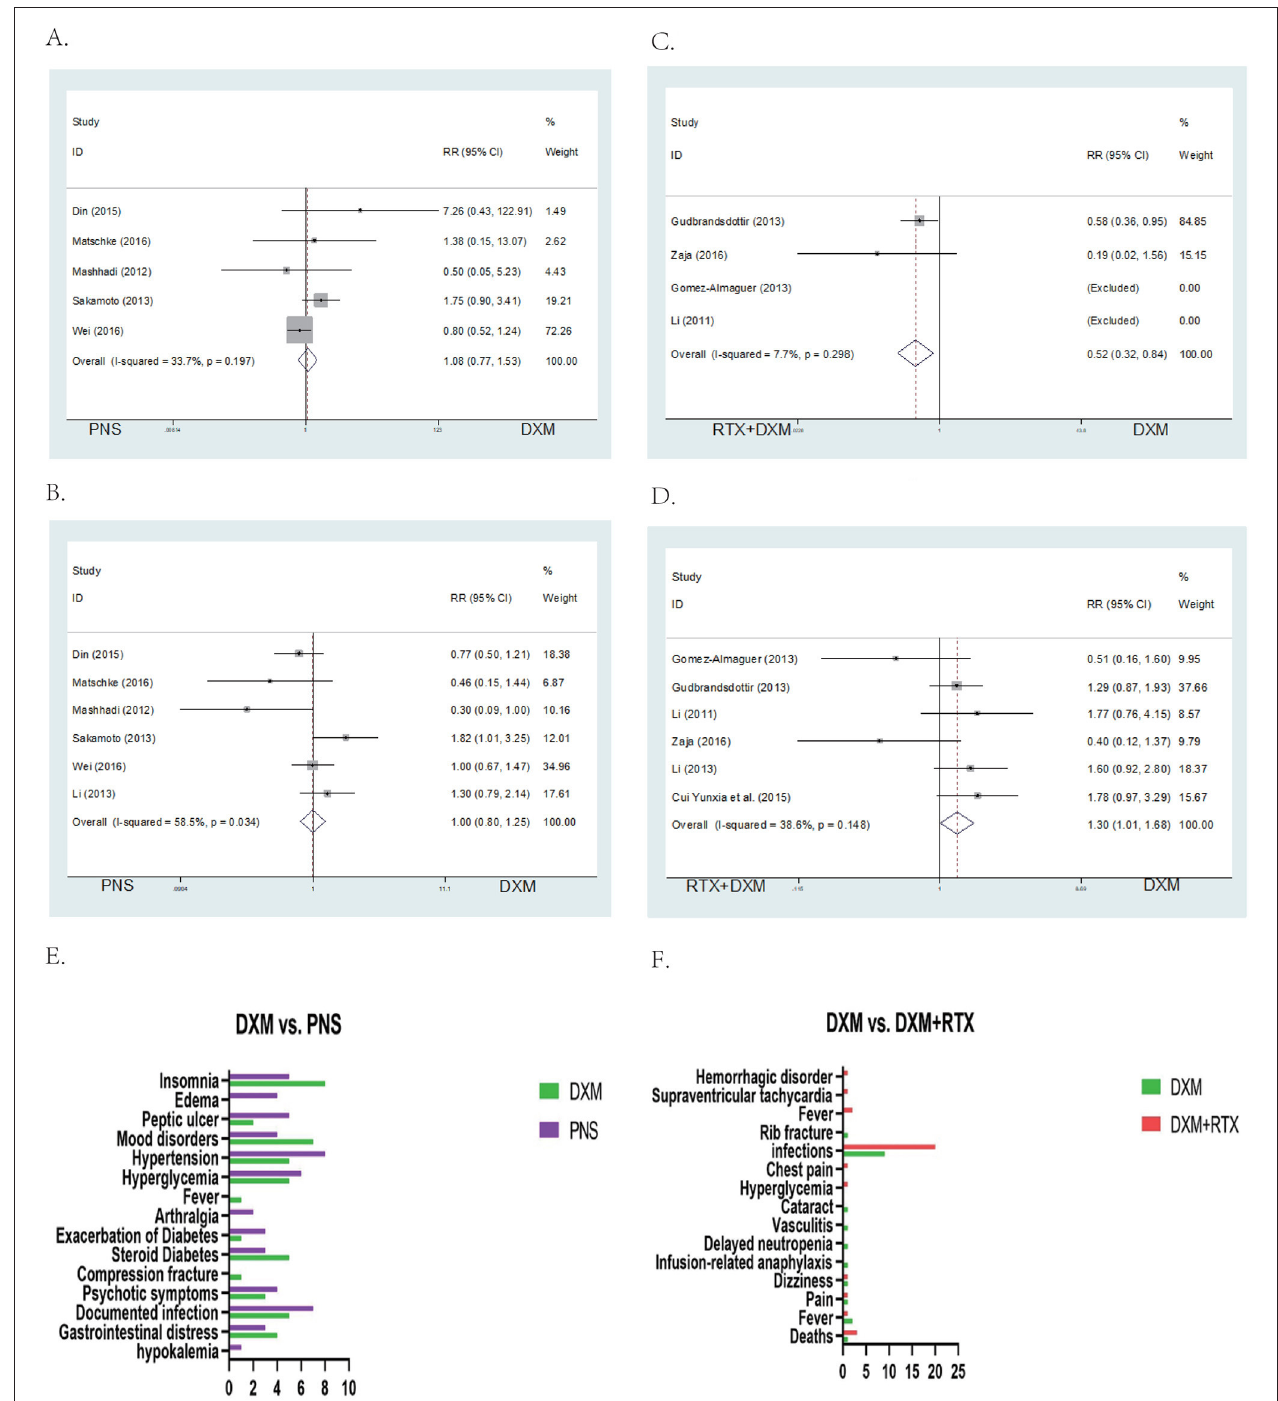
FIGURE 5 | Forest map of AEs or Relapse and bar of AEs. (A) DXM vs. PNS’s AEs. (B) DXM vs. PNS’s Relapse. (C) DXM vs. RTX + DXM’s AEs. (D) DXM vs. RTX + DXM’s Relapse. (E) AEs of DXM vs. PNS. (F) AEs of DXM vs. RTX + DXM.